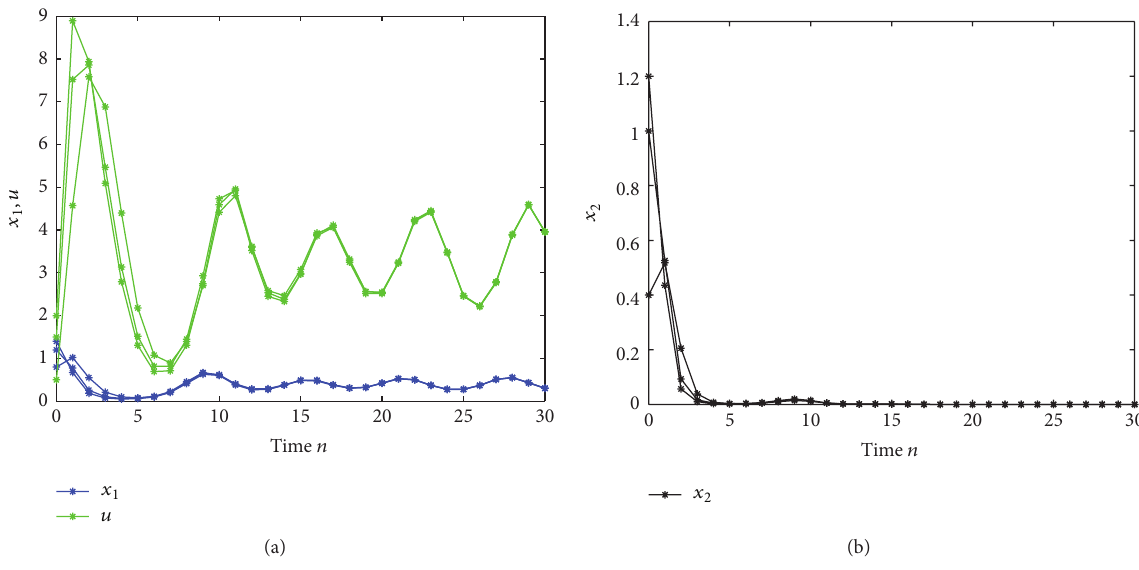
Figure 4: Numeric simulations of the solutions (𝑥 1 (𝑛),𝑥 2 (𝑛),𝑢(𝑛)) of system (110), with the initial conditions (𝑥 1 (𝑠),𝑥 2 (𝑠),𝑢(𝑠)) = (0.8,0.4, 0.5) , (1.4,1.2, 2) , and (1.2, 1.0, 1.5) , 𝑠 = ⋅⋅⋅ , −𝑛,−𝑛 + 1,...,−1,0 ,